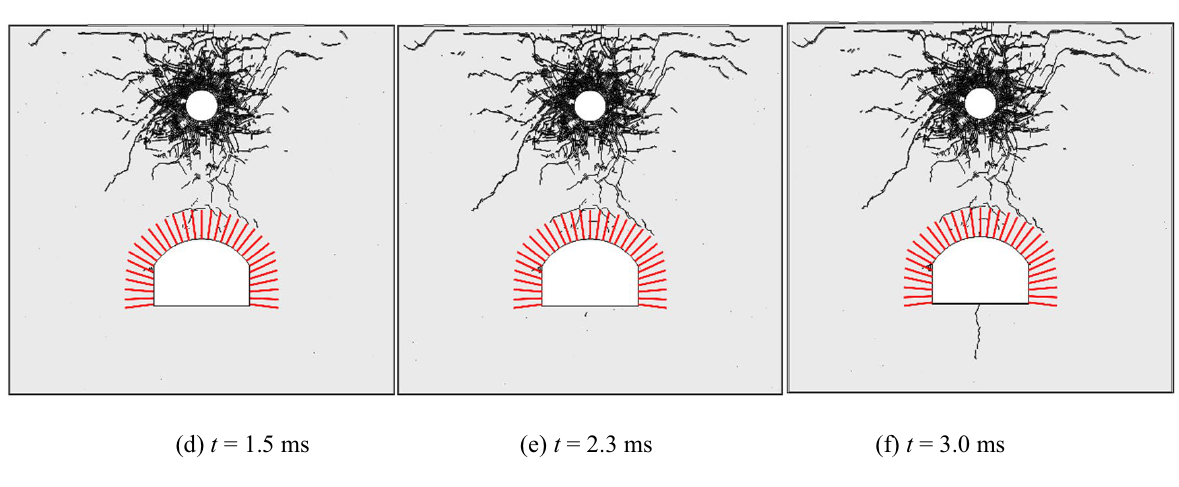
Figure 9. Crack propagation process of anchorage